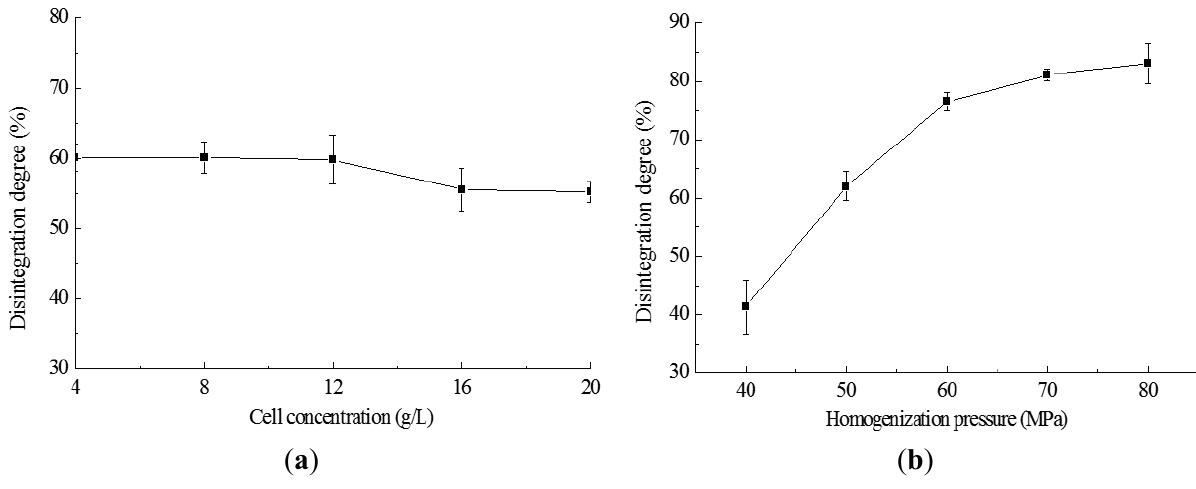
Figure 2. Effect of homogenization on the degree of cell disintegration. ( a ) The homogenization pressure was 50 MPa; ( b ) the suspension was at 20 g/L and homogenized for two